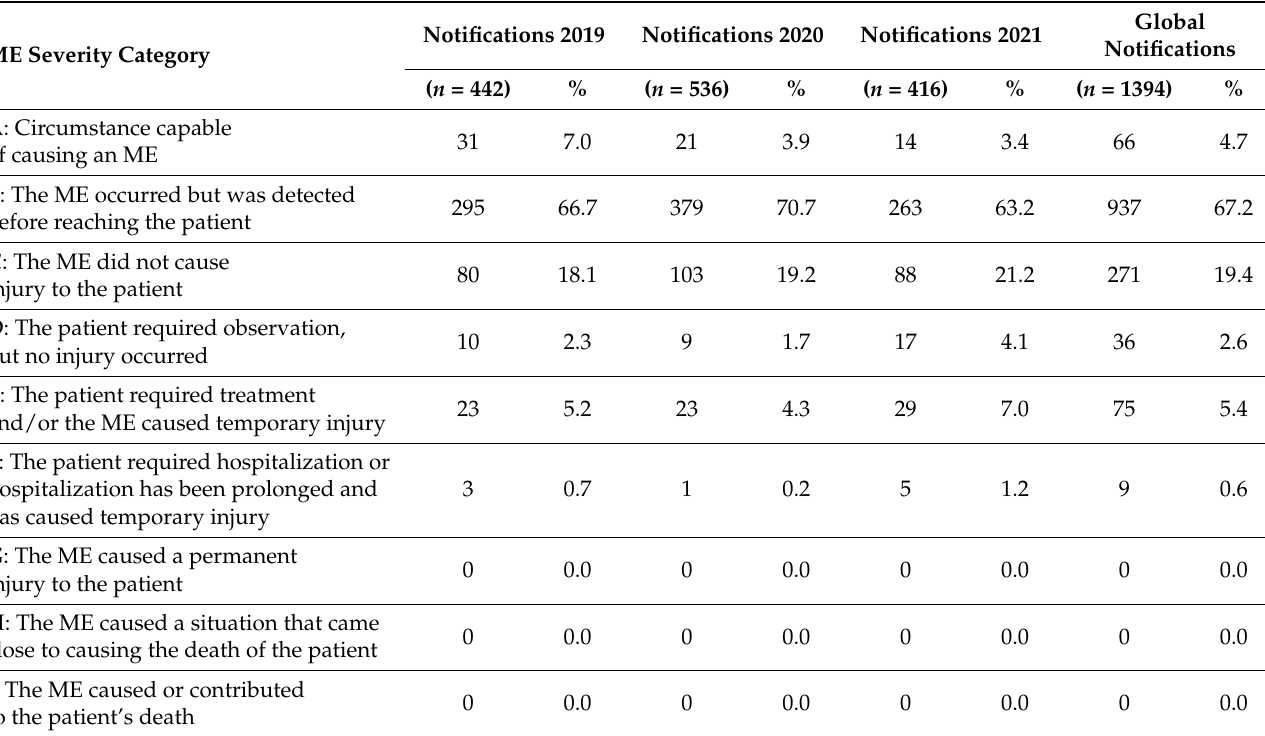
Table 2. Numbers and percentages of ME notifications based on severity category (Catalonia,